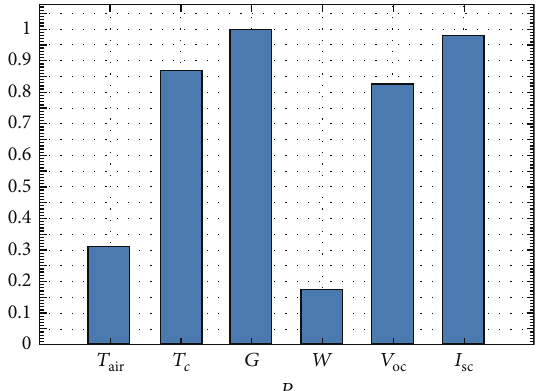
Figure 7: Correlation analysis between the power output and all input data of the Sanyo panel.